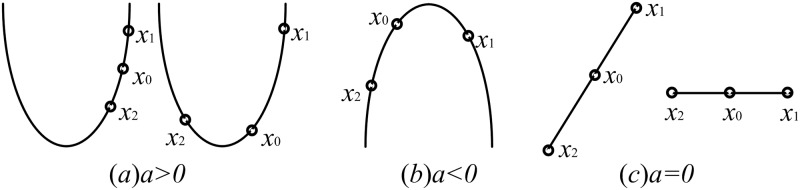
ForI ≠ 0, the different cases of the solution.